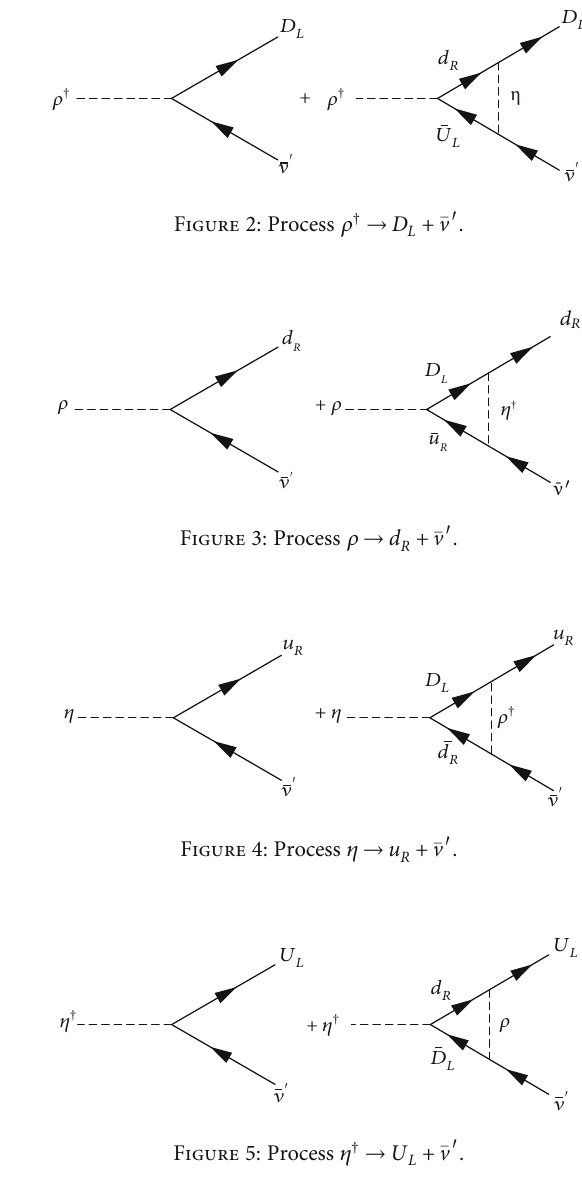
Figure 5: Process η † → U